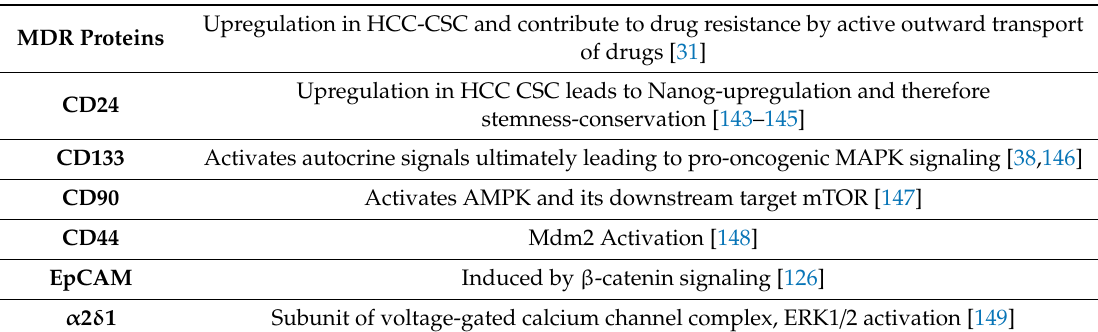
Table 1. Surface molecules linked to cancer stem cell (CSC) traits in HCC and their putative oncogenic and stemness supporting functions (Figure 1).